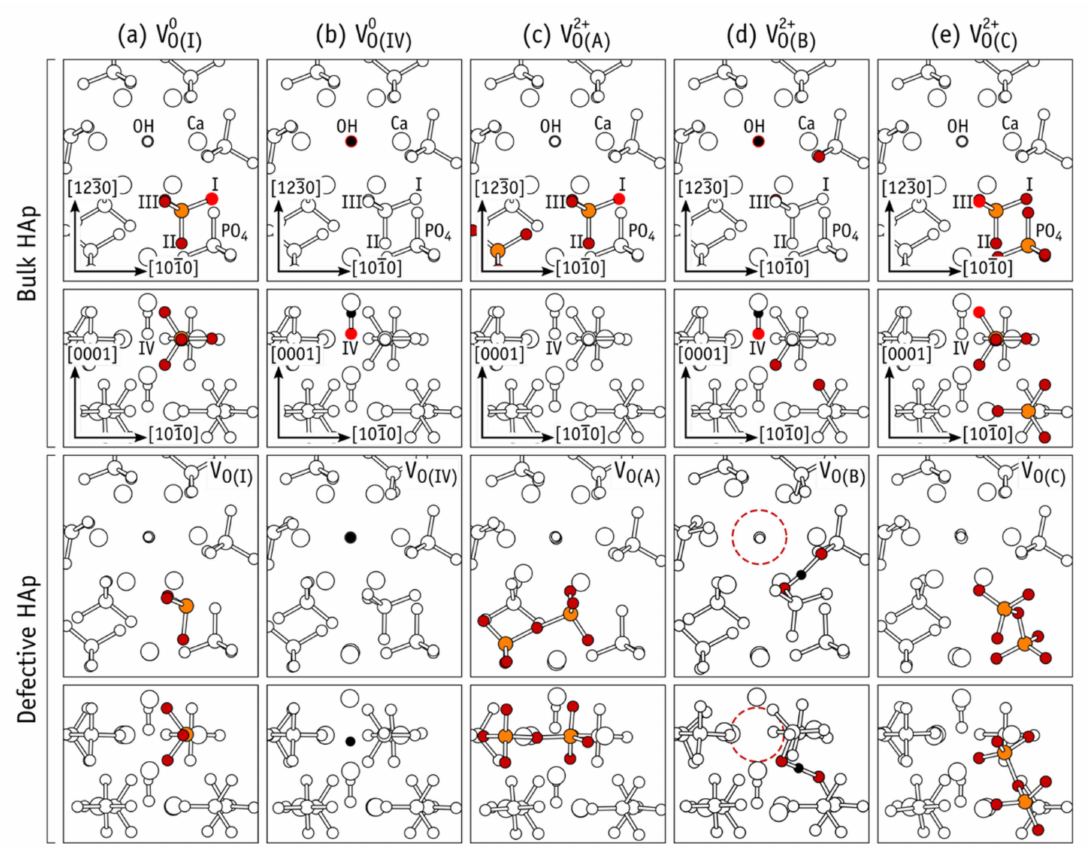
Figure 10. Diagrams showing “Bulk” (upper half) and “Defective” (lower half) HAP. For each row pair, upper and lower rows display the same structures viewed along the [0001] and [1230] directions of the hexagonal lattice, respectively. Formation of structures I, IV, A, B, and C of V O defects is explained in columns ( a – e ), respectively. Only atoms belonging to the core of the defect are colored (P, O, and H atoms are shown in orange, red, and black, respectively). Vacancies were created by removing the bright red O atom shown in the “Bulk” figures. Upon atomic relaxation, the resulting structures are those in the corresponding “Defective” figures. Reprinted with permission from [8]. (Adapted with permission from [8]. Copyright (2019) American Chemical